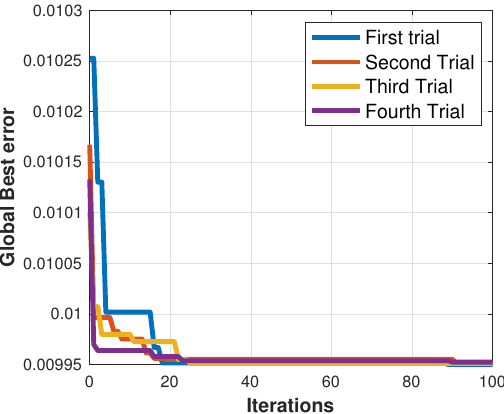
Figure 13. Convergence plot of the error through